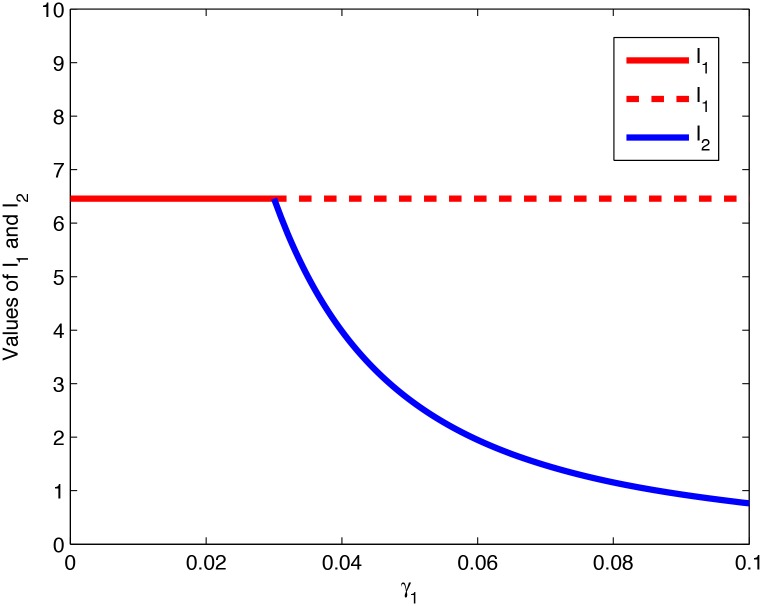
The way I
1 and I
2 vary with the increase of γ
1.